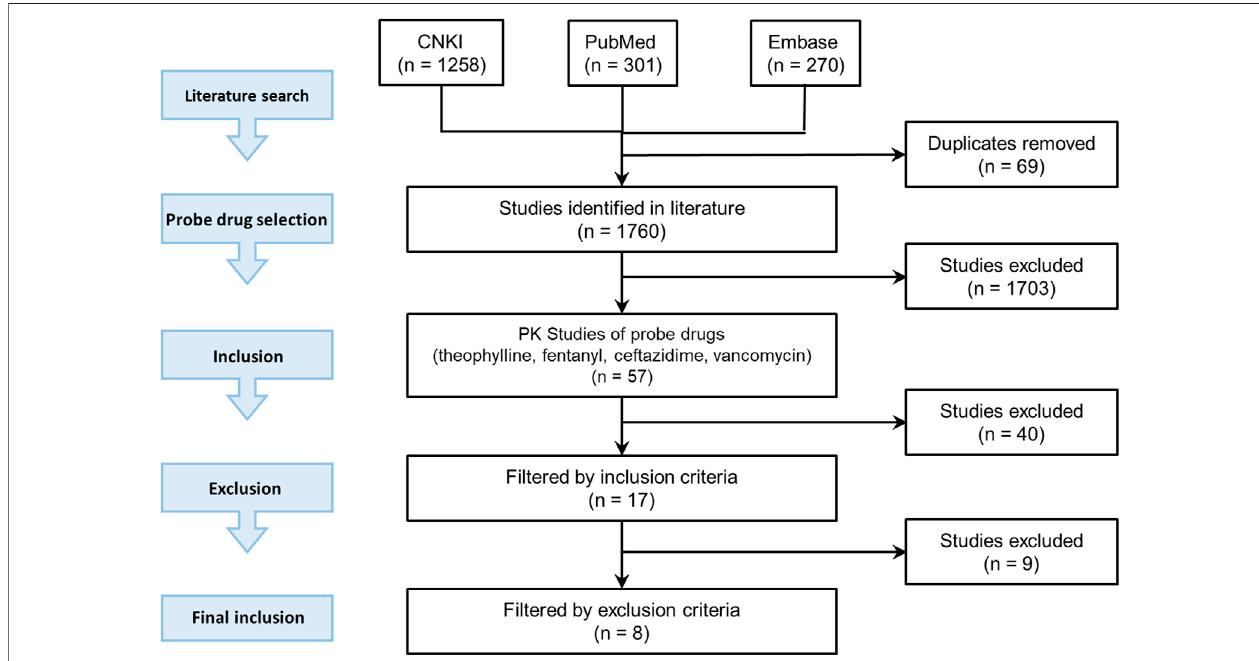
FIGURE 2 | Demonstration of literature search